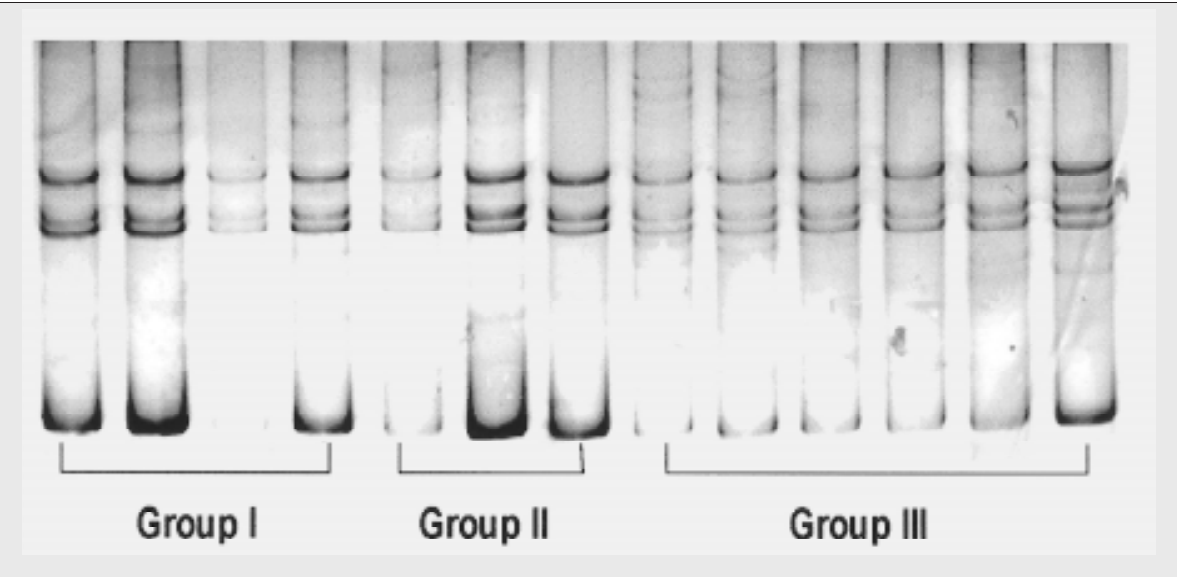
Figure 3 – PCR-SSCP showing no relevant alteration in a 14% polyacrylamide gel for exon 2 of oncogene H-RAS in group I (control, n = 4), group II (initiated, n = 3) and group III (initiated + PB, n =